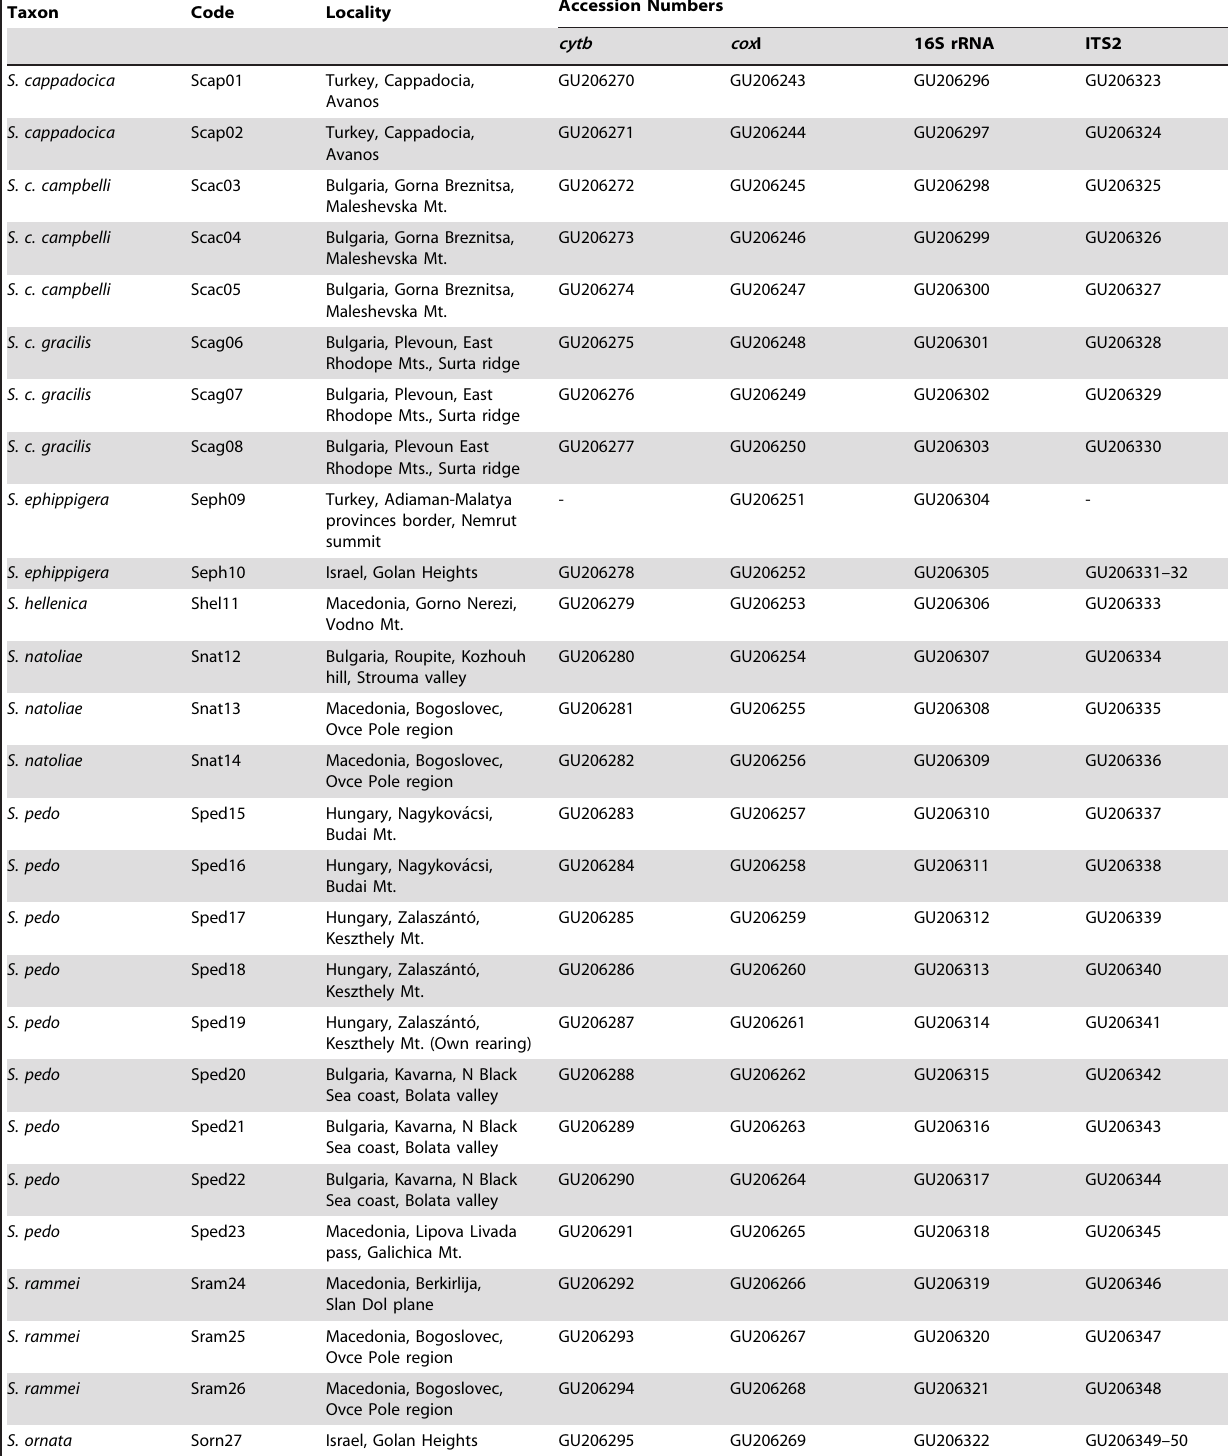
Table 1. Details of sample